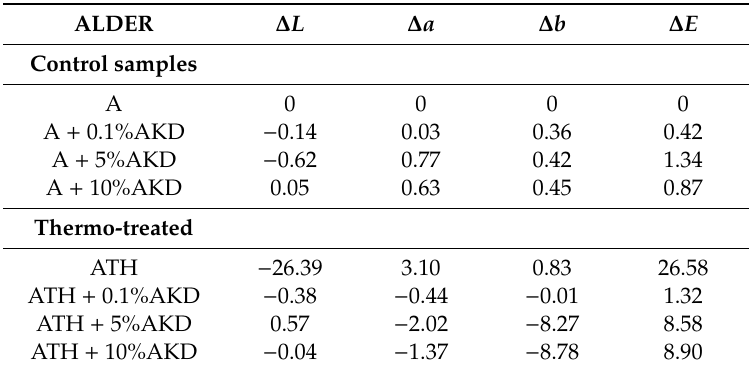
Table 2. The colour change (mean value) for both the treated and untreated alder. The colour variation of ATH samples are referred to A control samples.